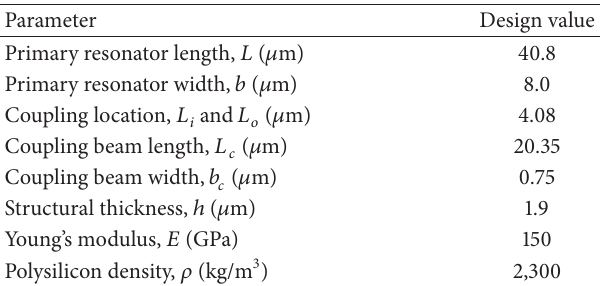
Table 1: Filter specifications